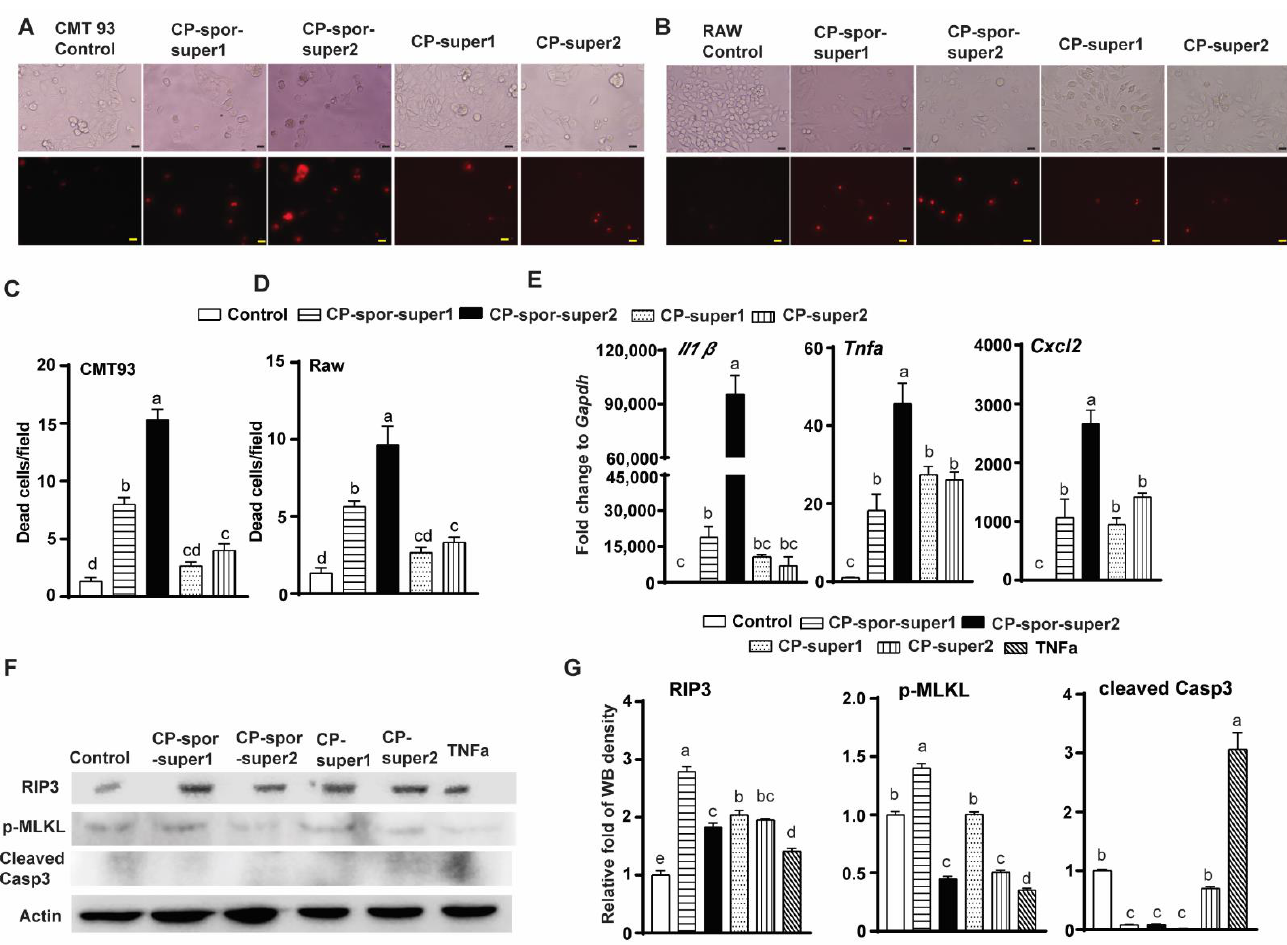
Figure 2. CP-spor-super1 or 2 induced intestinal epithelial cell (IEC) and macrophage cell necrosis. Cells were challenged with CP-super1&2 and CP-spor-super1&2. ( A , C ) Mouse IEC CMT-93 for 24 h (red of dead cells, propidium iodide (PI) staining). ( B , D ) Mouse Raw 264.7 macrophage for 24 h. ( E ) Raw cells to assess mRNA expression for 4 h. ( F ) Raw cell to assess protein expression by WB for 5 h. ( G ) WB quantification using ImageJ. All graphs depict mean ± SEM. Different letters mean significant. Results are representative of three independent experiments. Scale bar is 20 μm .